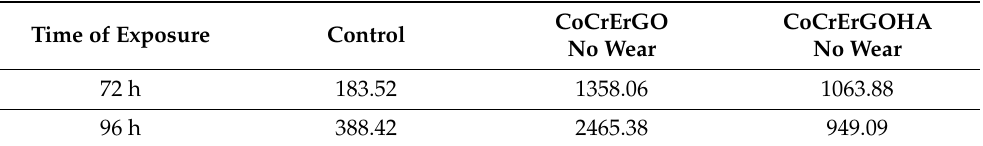
Table 1. Secreted TNF- α levels (pg/mL) of J744A.1 macrophages in response to the modified surfaces